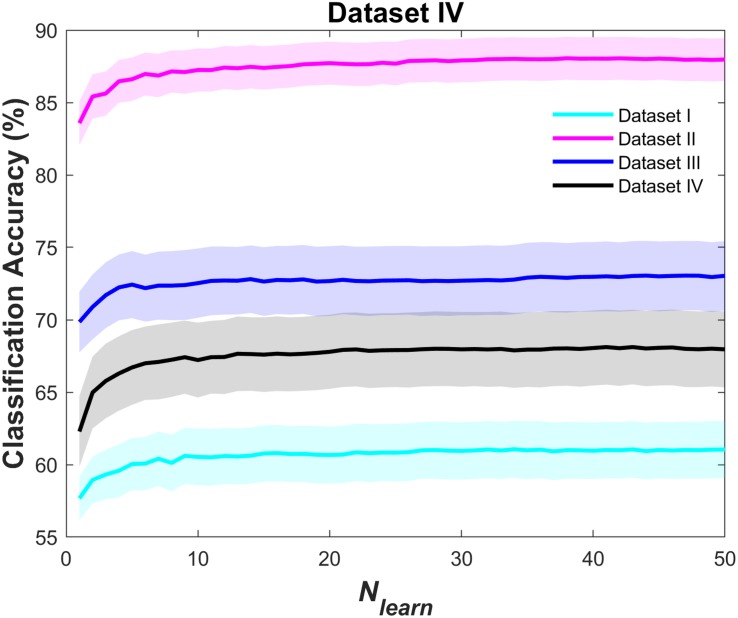
Grand average of accbag as a function of Nlearn for dataset I (cyan), dataset II (magenta), dataset III (blue), and dataset IV (black). The shaded area represents the standard error of the mean.